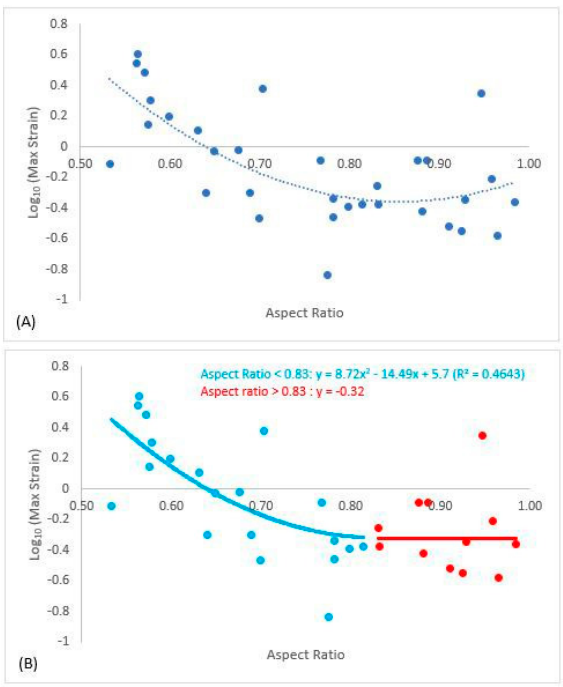
Figure 6. Polynomial best fit line between Log 10 (MaxStrain) and aspect ratio ( A ). Spline regression determined that the data plateaued when aspect ratio was greater than 0.83. The second graph ( B ) reports the regression equation for Log 10 (MaxStrain) and aspect ratio for lateral unions and the plateau value ( − 0.32) for Log 10 (MaxStrain) for codominant unions when aspect ratio was greater than 0.83.